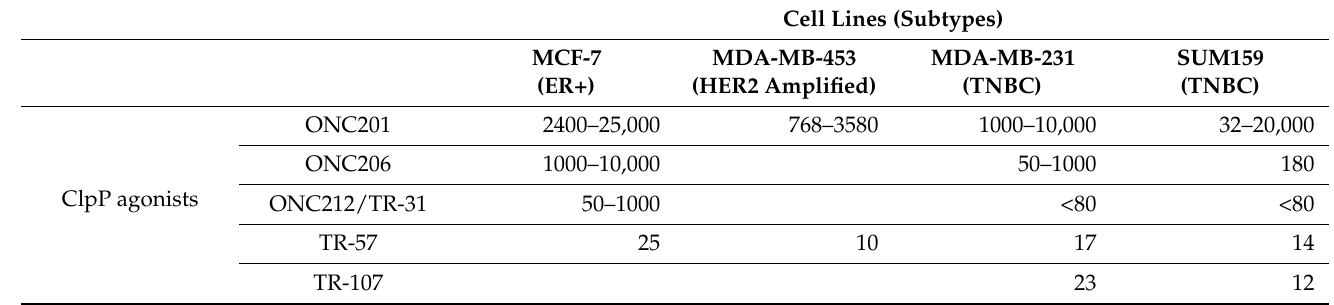
Table 2. Comparison of IC 50 (nM) of ClpP agonists in representative breast cancer cell